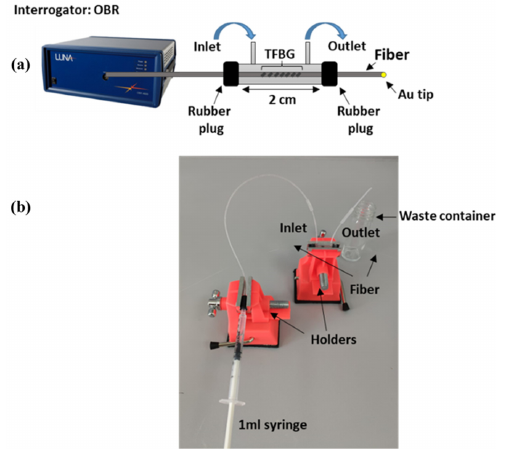
Figure 1. Experimental setup for fiber etching: ( a ) Schematic overview of the setup; and ( b ) Corre- sponding real image: TFBG was immersed in a closed compartment (cylinder) with 48% HF (during etching stage) or with different sucrose solutions (during RI calibration). The container had two ports: an inlet where the sample was injected using a 1 mL syringe and an outlet which was linked to the waste container.